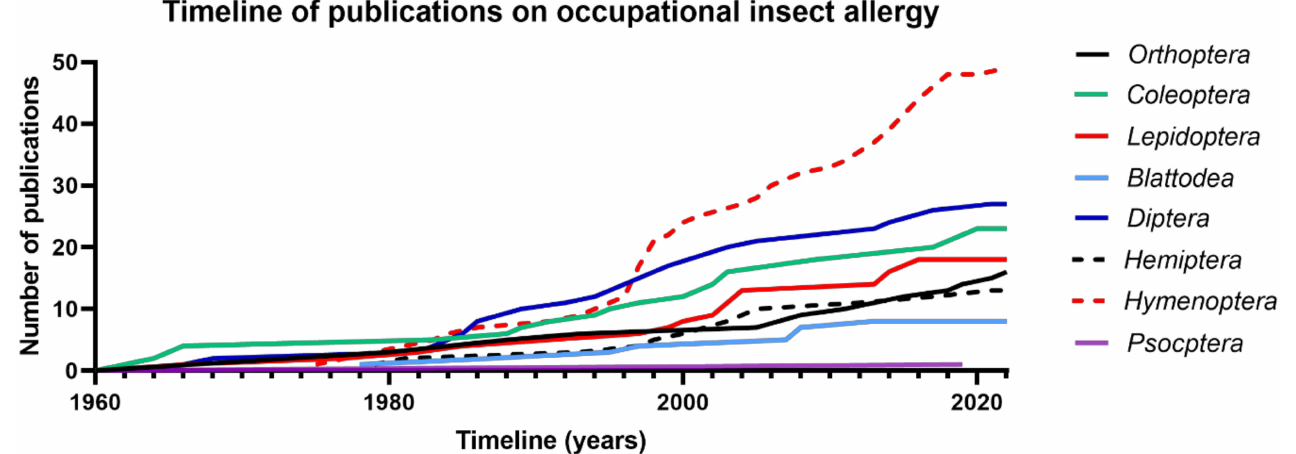
Figure 2. Evolution of the number of publications on occupational insect allergy. Only two publica- tions were made before 1960 and were excluded from this